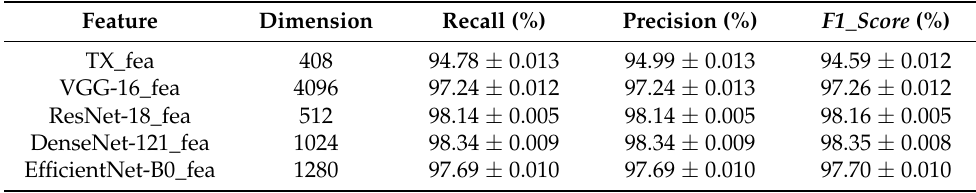
Table 2. Performance of different features in Mars dataset.